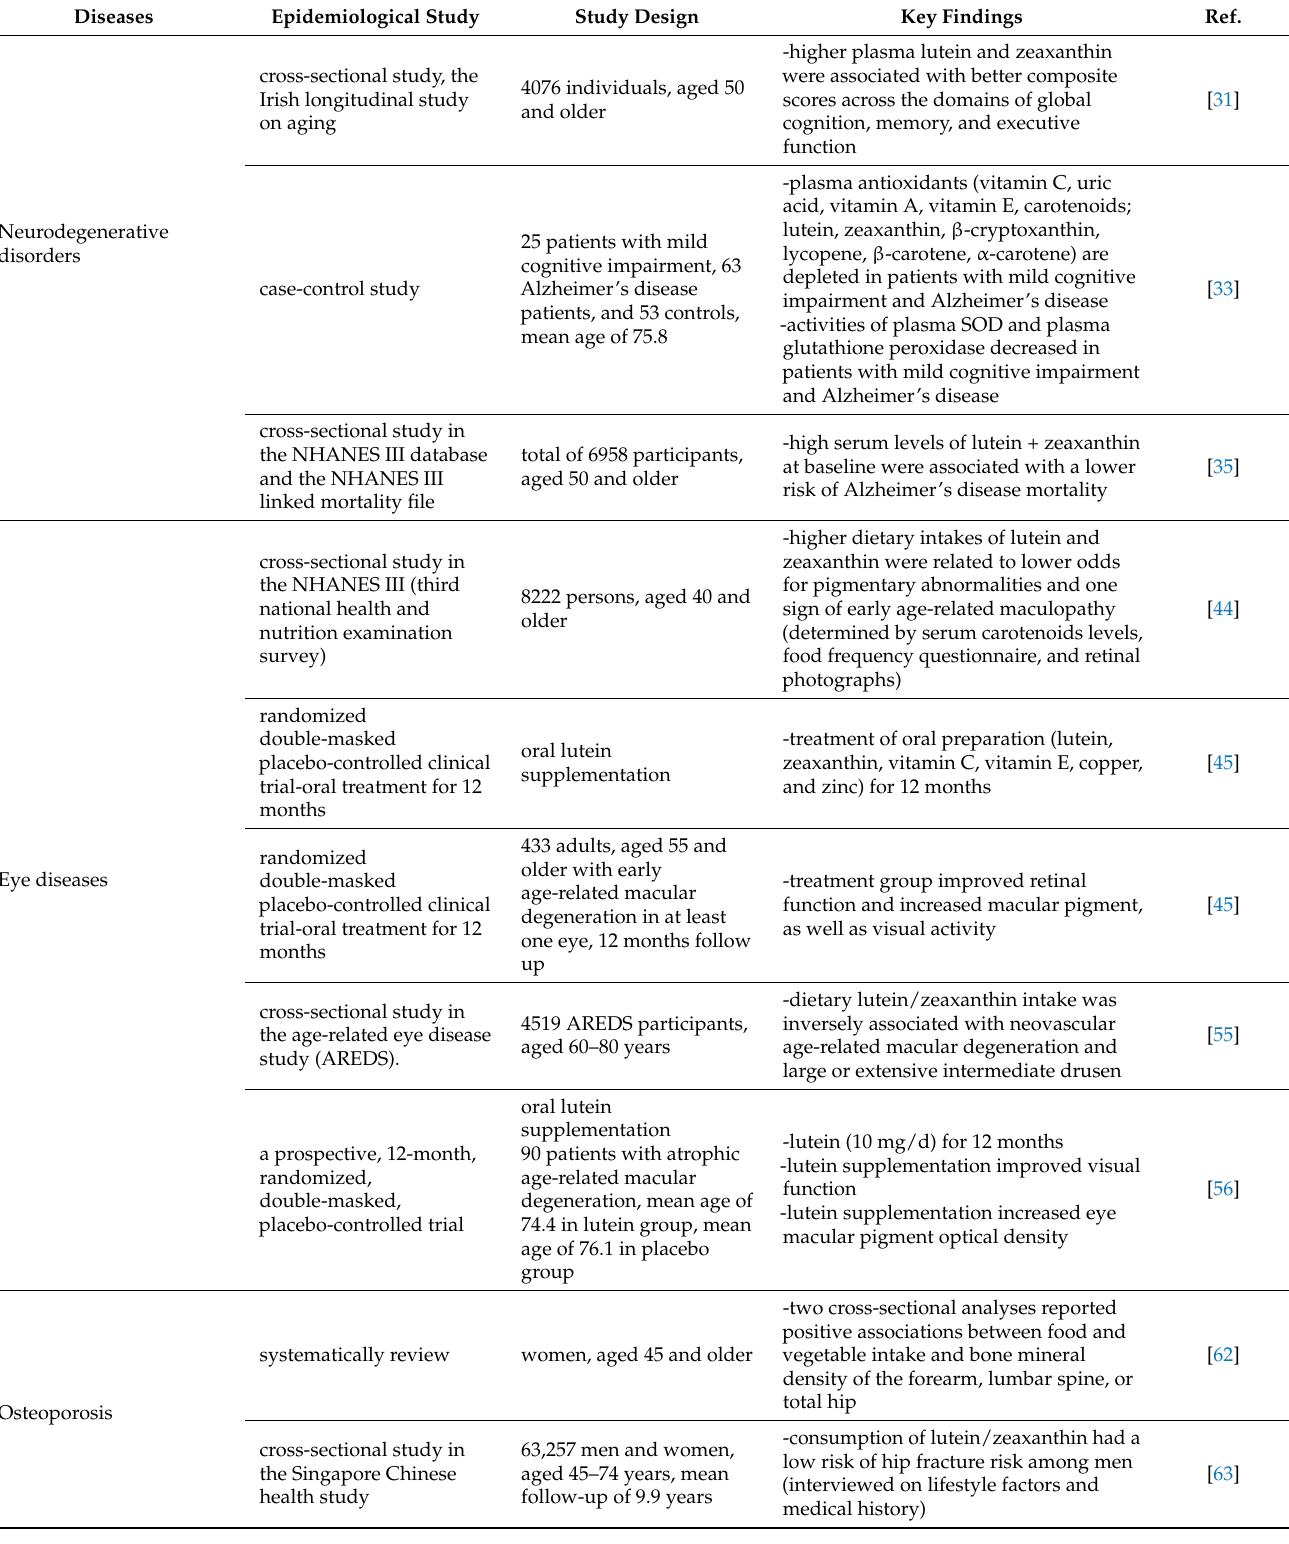
Table 2. The effects of lutein on inflammatory responses in epidemiological